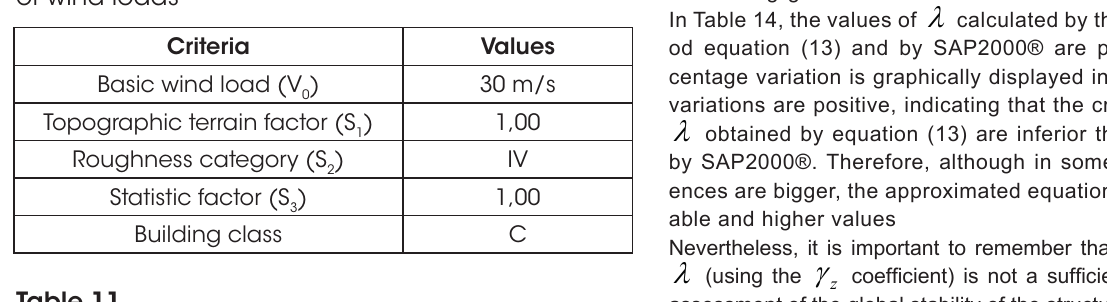
Adopted parameters for the calculation